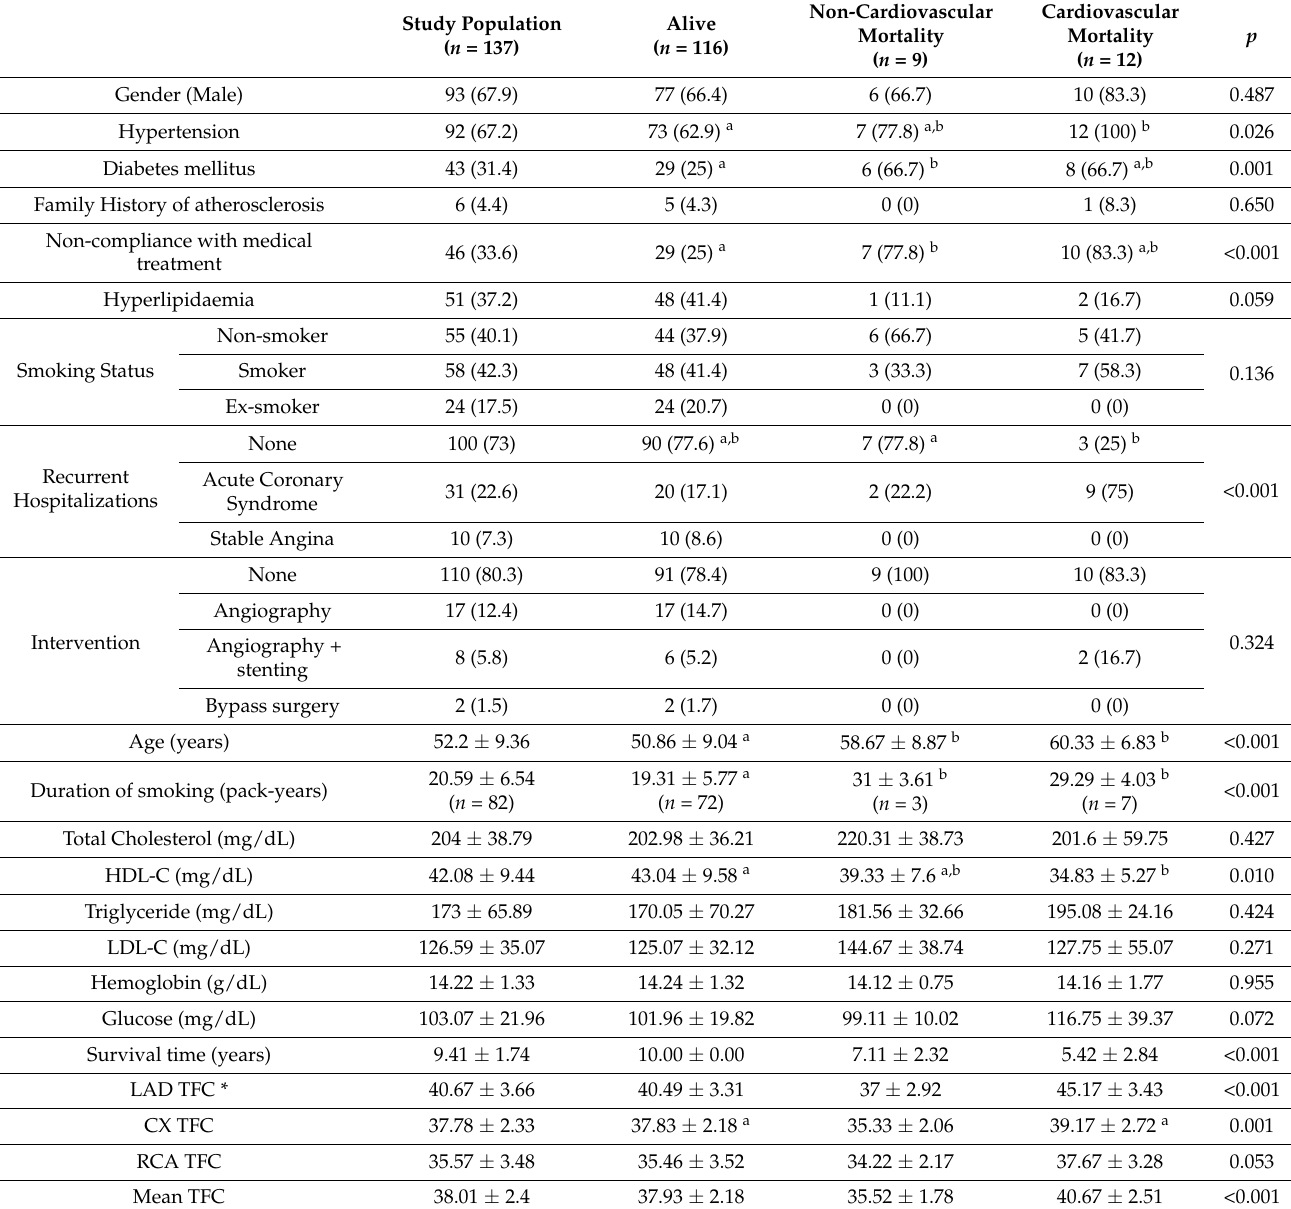
Table 1. Study population and comparisons of demographic and clinical characteristics among patients who are alive, those who experienced cardiovascular deaths, and those who experienced non-cardiovascular